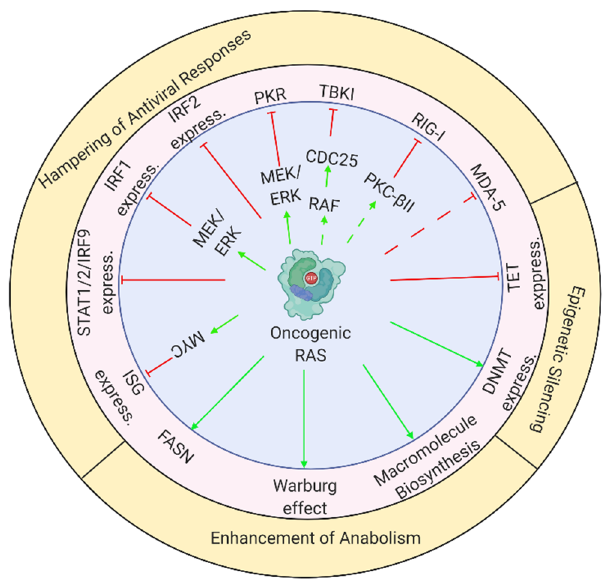
Figure 1. Oncogenic RAS supports viral infection through multiple molecular mechanisms. Scheme depicts mechanisms described throughout review. Green arrows or blunt red arrows denote stimulation or inhibition, respectively. Dashed arrows indicate cases where one source of information supports the connection between oncogenic RAS and its effector, and another source supports the link between the effector and the oncolysis-regulating mechanism. The figure was created with BioRender.com (accessed on 12 February 2021).